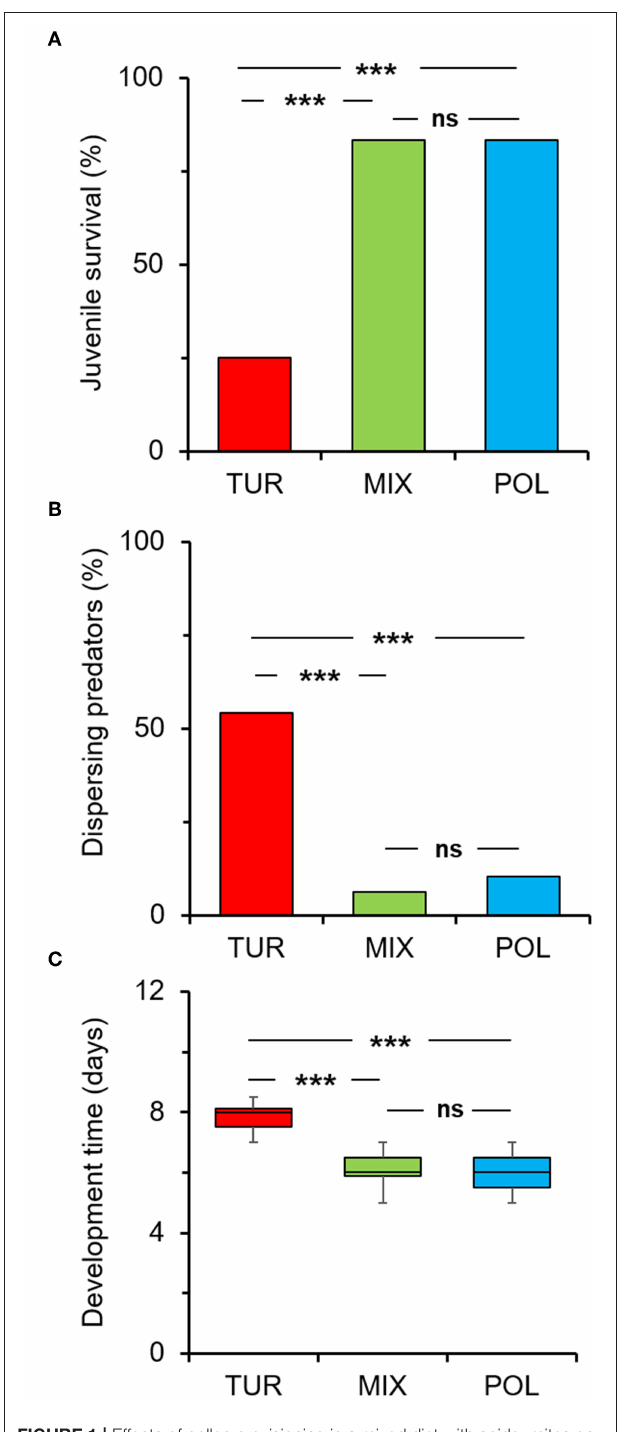
FIGURE 1 | Effects of pollen provisioning in a mixed diet with spider mites on the development and dispersal of Amblydromalus limonicus juveniles. Eggs laid by predator females within 24h were individually transferred on leaf discs where juveniles ( n = 48 per treatment) had access to either Typha latifolia pollen (blue bar, POL), spider mite larvae (red bar, TUR), or a mixed diet consisting of spider mite larvae plus pollen (green bar, MIX) throughout their development to adults. (A) Percentage of juvenile survival at reaching